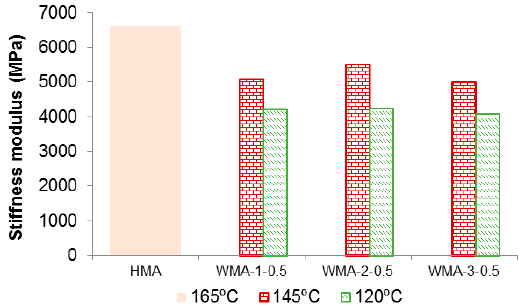
Figure 3. Stiffness modulus at 20 °C for the mixtures with different additives.